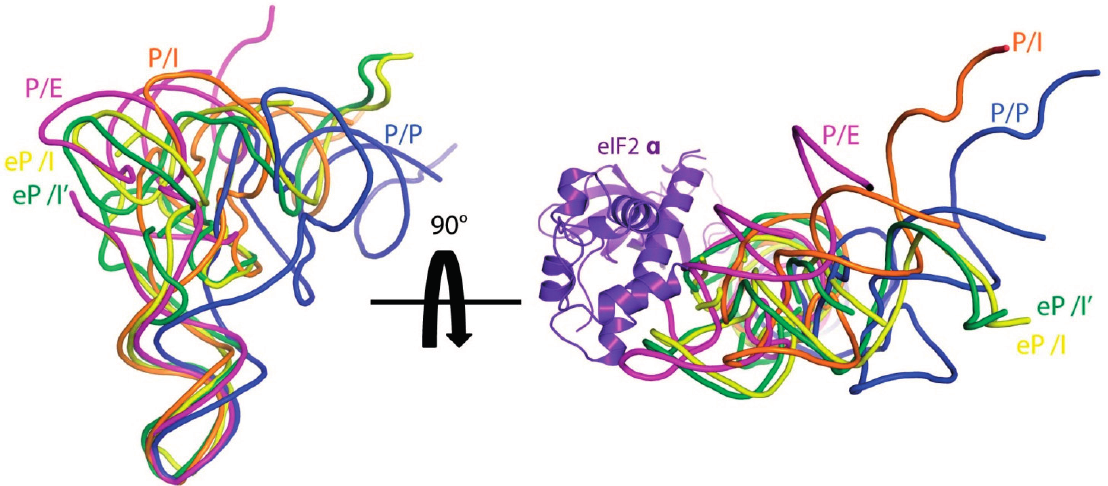
Figure 3. Comparison of tRNA structures from different eukaryotic initiation